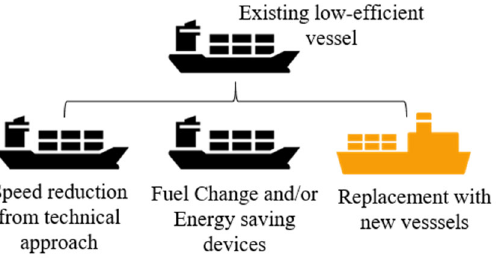
Figure 3. Multiple options for design improvement according to